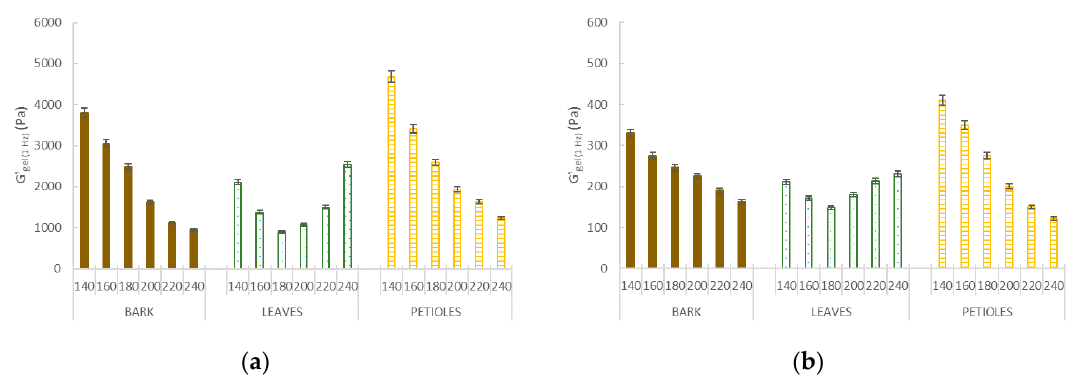
Figure 4. Impact of the autohydrolysis processing temperature (°C) on the viscoelastic features, G’gel (1 Hz), of all tested hydrogels formulated with ( a ) starch and ( b ) gelatin. Symbols: bark (filled bars), leaves (dotted bars), petioles (dashed bars).